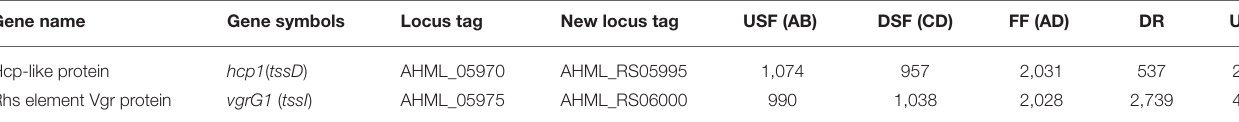
TABLE 4 | The sizes of upstream (USF), downstream (DSF), and in-frame fused fragments (FF), deleted region (DR), and undeleted region (UD) by base pair